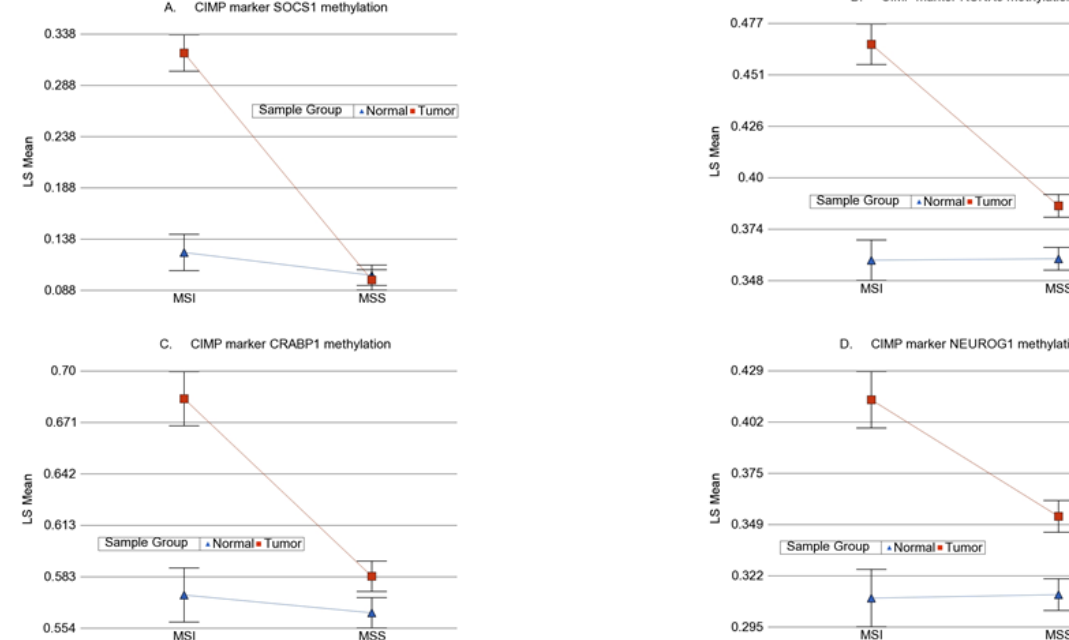
Figure 7. Examples of the interaction of MSI with differential methylation in some of the reported CIMP genes. Each figure suggests a greater differential methylation in MSI tumors (shown in red) compared to corresponding healthy tissue (shown in blue), but in most cases, the magnitude of differential methylation did not exceed 20%. The methylation changes in SOCS1 , RUNX3 , CRABP1 and NEUROG1 genes are shown in ( A ), ( B ), ( C ) and ( D ) respectively.